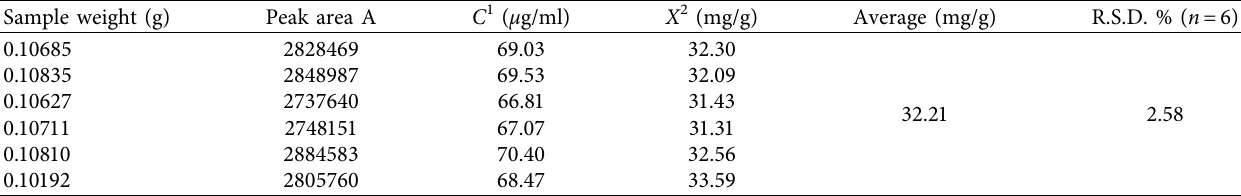
Table 4: The results of determination of the samples.